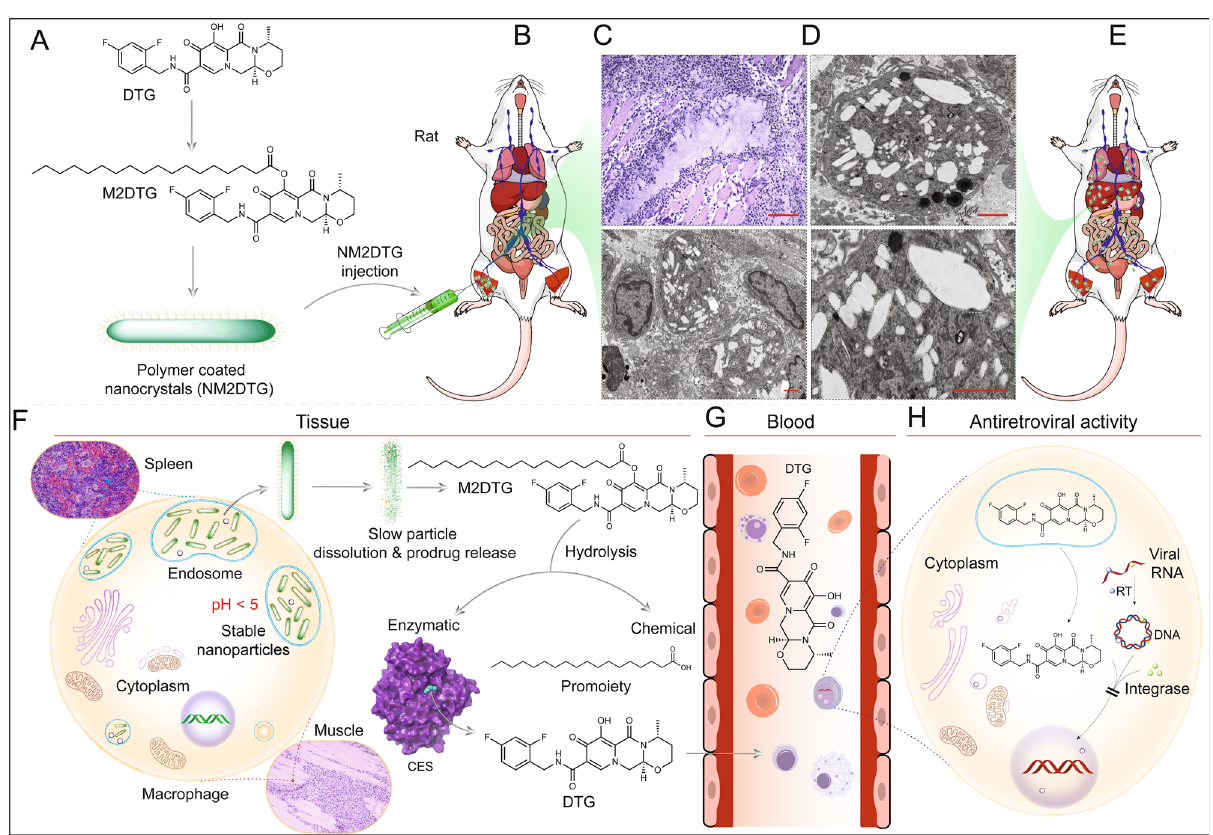
Fig. 8 Illustration of NM2DTG extended PK pro fi le. The illustration shows the sequential steps determining the in vivo fate of the NM2DTG nanoformulation. A DTG was fi rst esteri fi ed with an 18-carbon fatty acid to produce M2DTG which was then nanoformulated to yield NM2DTG. B Intramuscular injection of NM2DTG illustrates the formation of the primary drug depot from which the prodrug dissolves from the nanoformulation. C , D Histiocytic in fi ltration ensues at the injection site leading to NM2DTG uptake by macrophages. N = 3 biologically independent animals/group with representative images shown. Scale bars — 400 µ m ( C , upper), 2 µ m ( C , lower; D , upper and lower). E Biodistribution of drugs to HIV-1 target organs among other tissue sites leads to sustained drug levels in liver, spleen, lymph node, and lung end organs. F M2DTG is slowly dissolved from the nanoformulation in the low pH microenvironment in macrophages and then hydrolyzed to release DTG. G The slow rate of dissolution of the DTG nanocrystals from tissues and rapid hydrolysis of M2DTG prodrug in plasma allow active DTG to enter the bloodstream and subsequent antiretroviral activities. The two-stage process of dissolution and hydrolysis leads to plasma DTG concentrations at or above the PA-IC 90 , for up to 1 year. H DTG shows potent integrase strand inhibition to the integration of viral DNA into the host